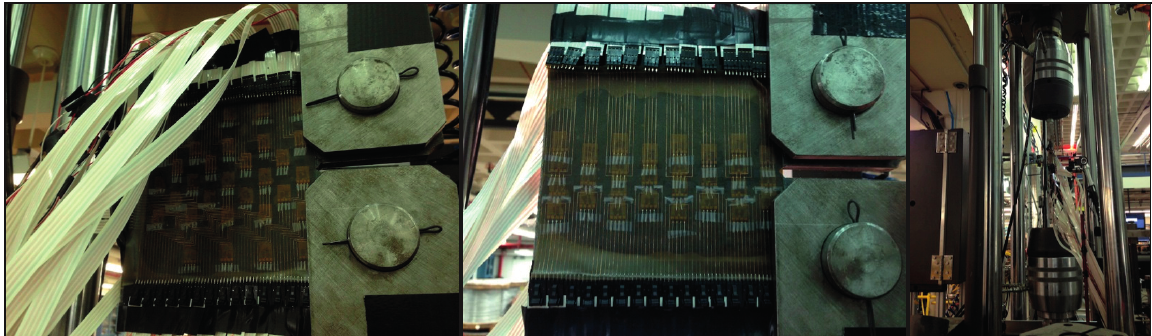
Figure 12. Left : Cable connections of sensing sheet Design 1 (for samples 2 and 4); Middle : Cable connections of sensing sheet Design 2 (for samples 1 and 3); Right : side view of cable connections and test